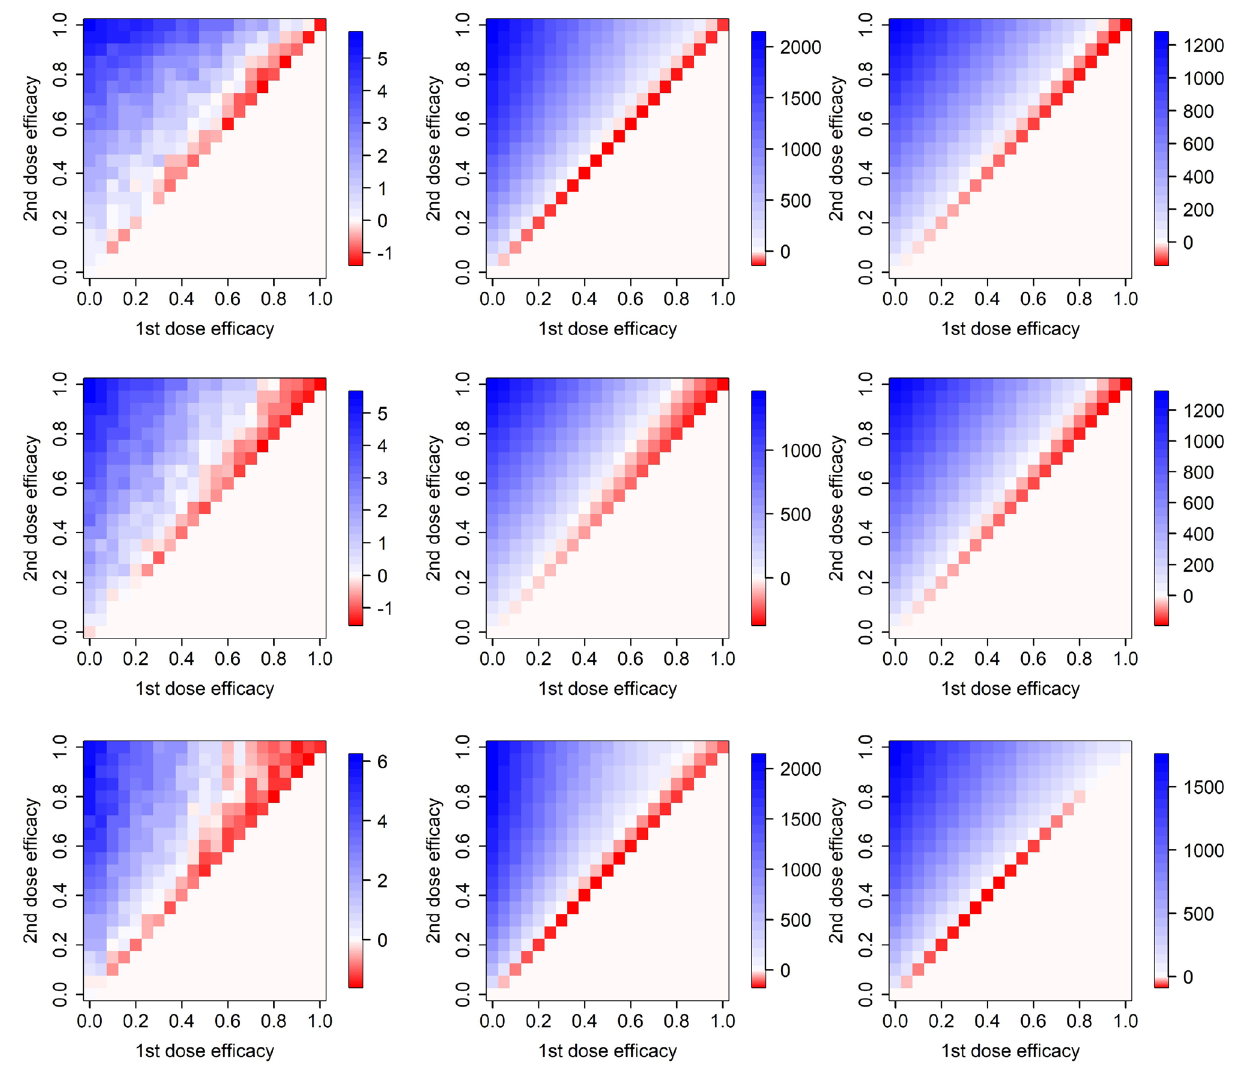
infected, second row: vaccine effect on the probability of becoming symptomatic when infected, bottom row: combination of effects on infection and symptoms appearance. Left column: model M, middle column: model H, right column: model